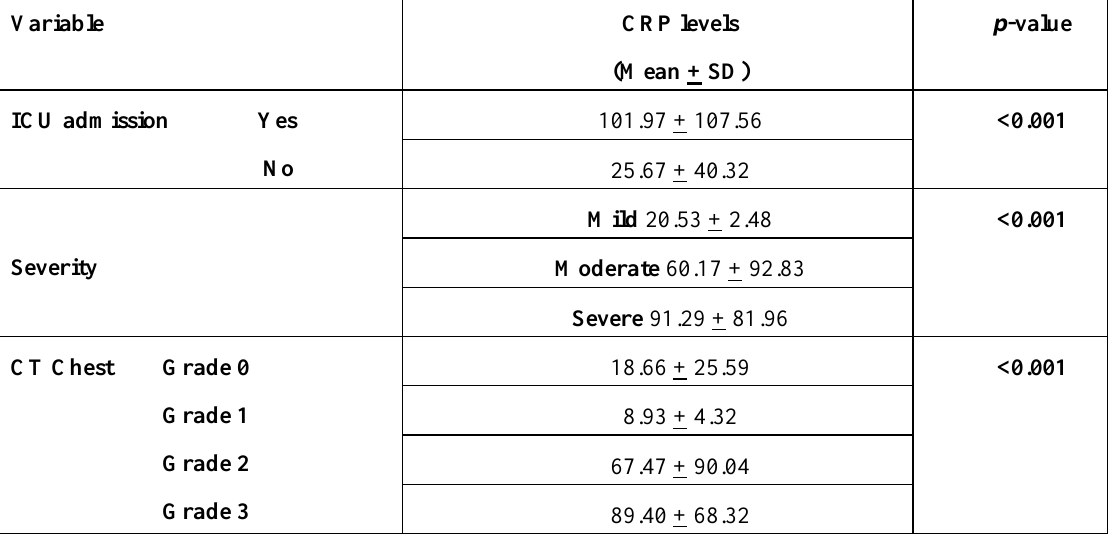
Table 3. Comparison between CRP levels (mg/L) according to ICU admission and severity at hospital admission.